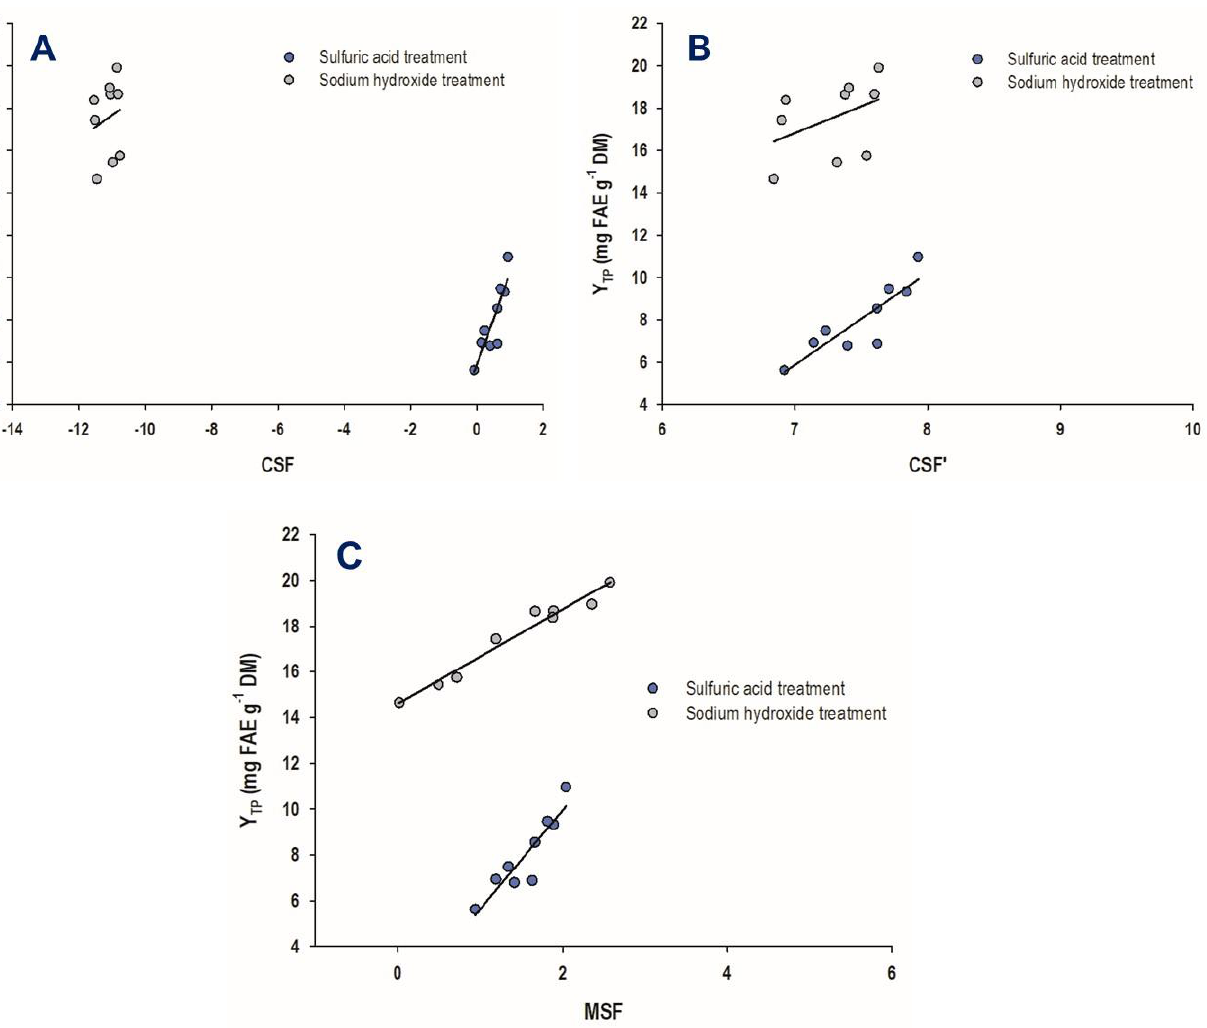
Figure 2. Linear regressions established between the yield in total polyphenols (Y TP ) and the com-